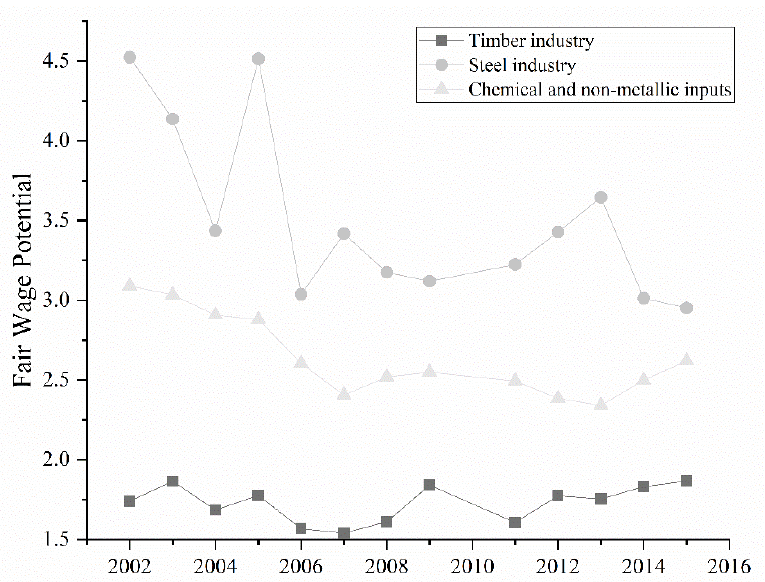
Figure 5. Fair wage potential for the considered industries.